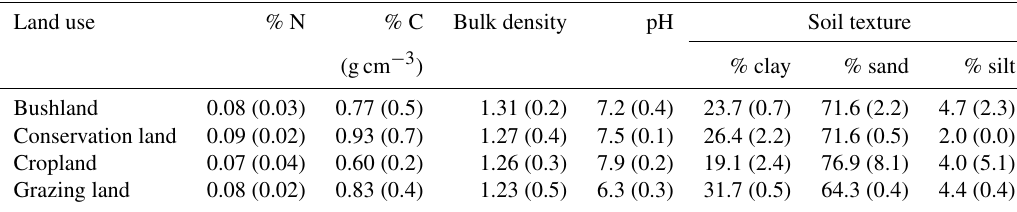
Figure 3. (a) Daily maximum and minimum air temperature and (b) daily rainfall from lowland in southern Kenya between November 2017 to October 2018 recorded at Maktau weather station. Total annual recorded rainfall was 550mm. Highlighted grey bars show the days of the sampling campaigns (the season labels above the grey bars are SW and LW for the short and long wet seasons and SD and LD for the short and long dry seasons; onset, mid, and end denote the onset, middle and end of the corresponding wet season). Table 1. Soil characteristics of the topsoil (a depth of 0–20cm) from the four land-use types investigated in this study. Values are given as mean ±